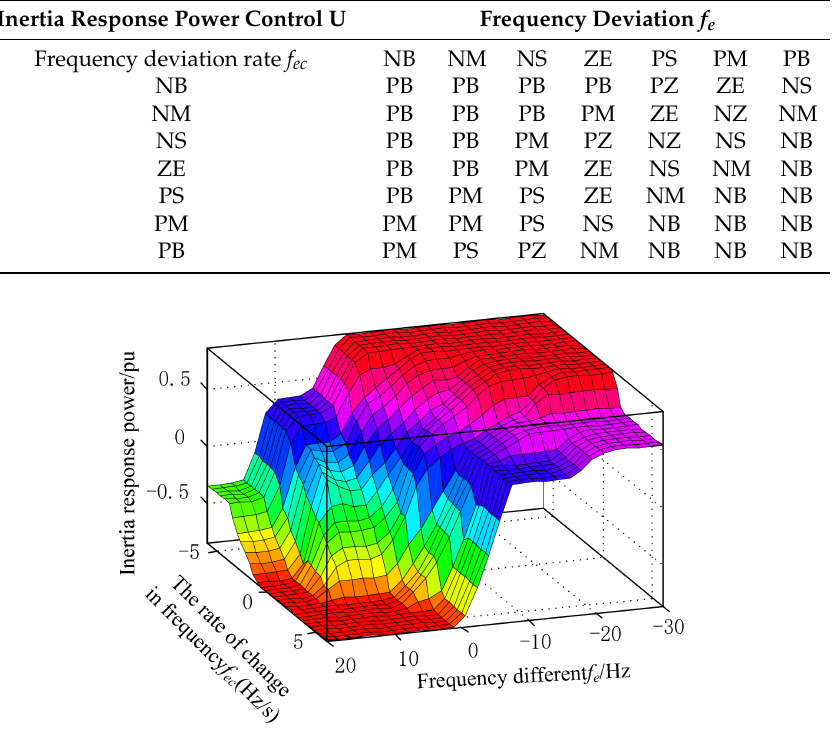
Figure A3. Result of fuzzy logic